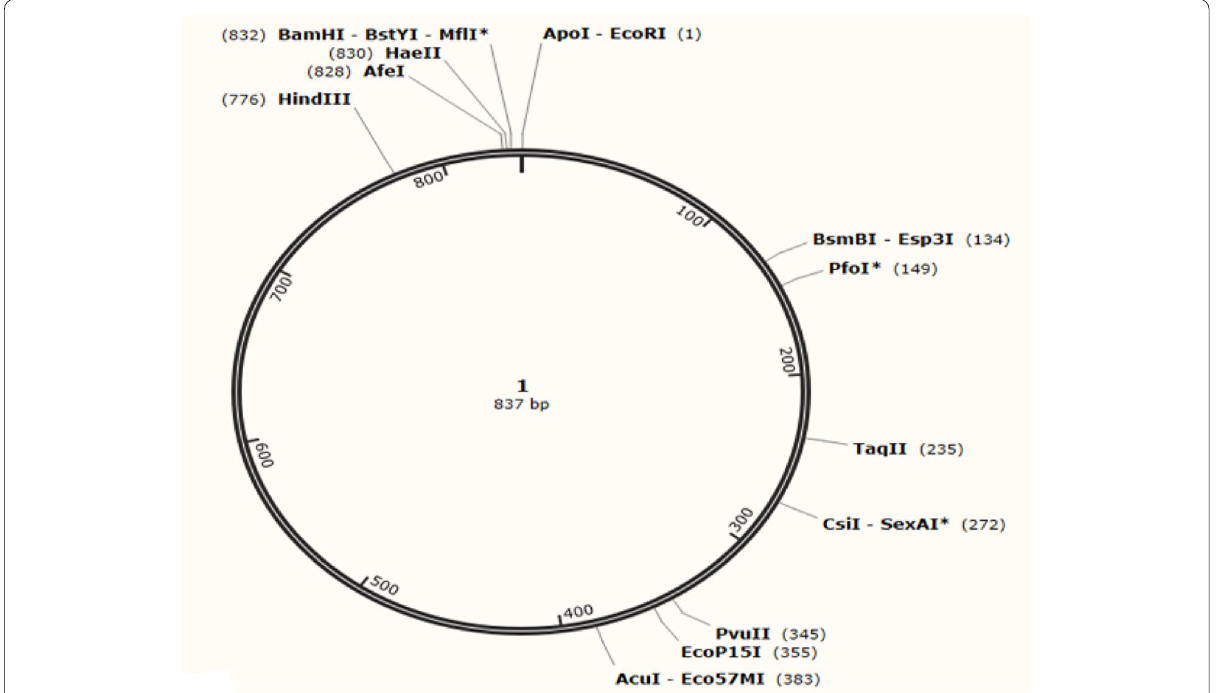
Fig. 12 The in silico restricted cloning of the vaccine in plasmid vector PIB2 .5A. Shows the insertion of the EcoRI and BamHI in